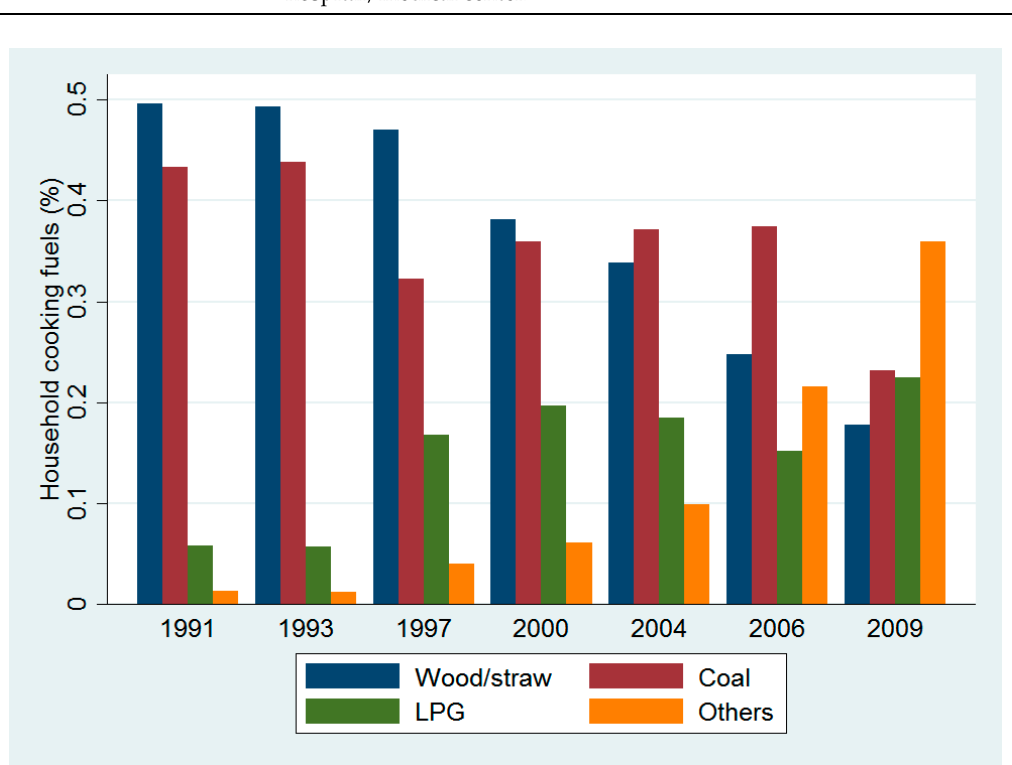
Figure A1. Temporal change of domestic cooking fuels from 1991 to 2009, China Health and Nutrition Survey. Note: LPG denotes liquefied petroleum gas and others represent electricity, kerosene, natural gas, charcoal and other unspecified fuels for cooking.